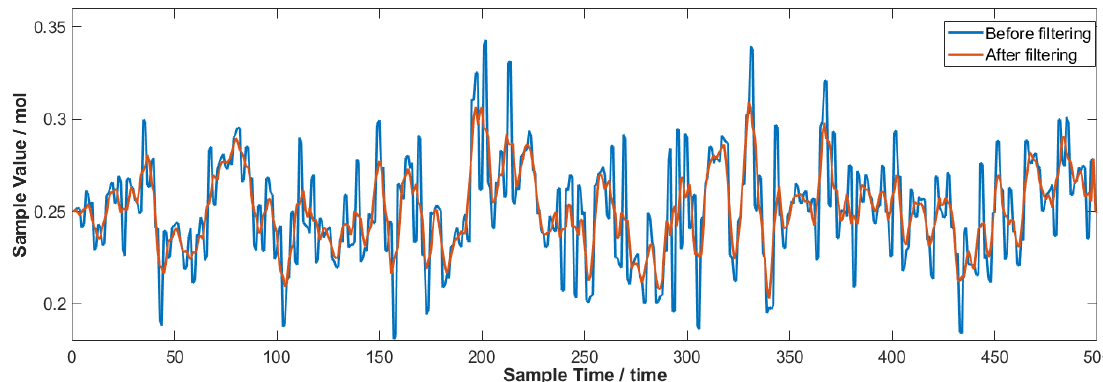
Figure 3. Comparison diagram before and after filtering.